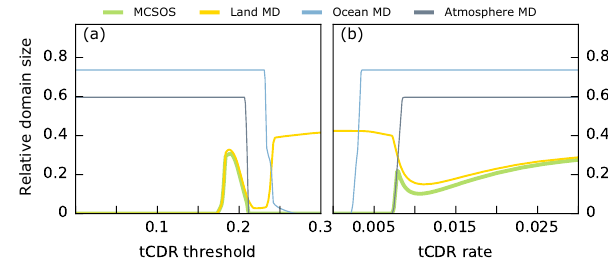
0.1 0.2 Figure 7. Relative size of domains in modelled carbon-system initial-condition state space for normalised parameter variation of (a) tCDR threshold (with α max = 0 . 02) and (b) tCDR rate (with f C a = 0 . 2) for a medium emission scenario ( c max = 0 . 4 ∼ 1600GtC cumulative emissions). All domain sizes are given as shares of the state space region defined by a variation of the pre- industrial conditions by ±